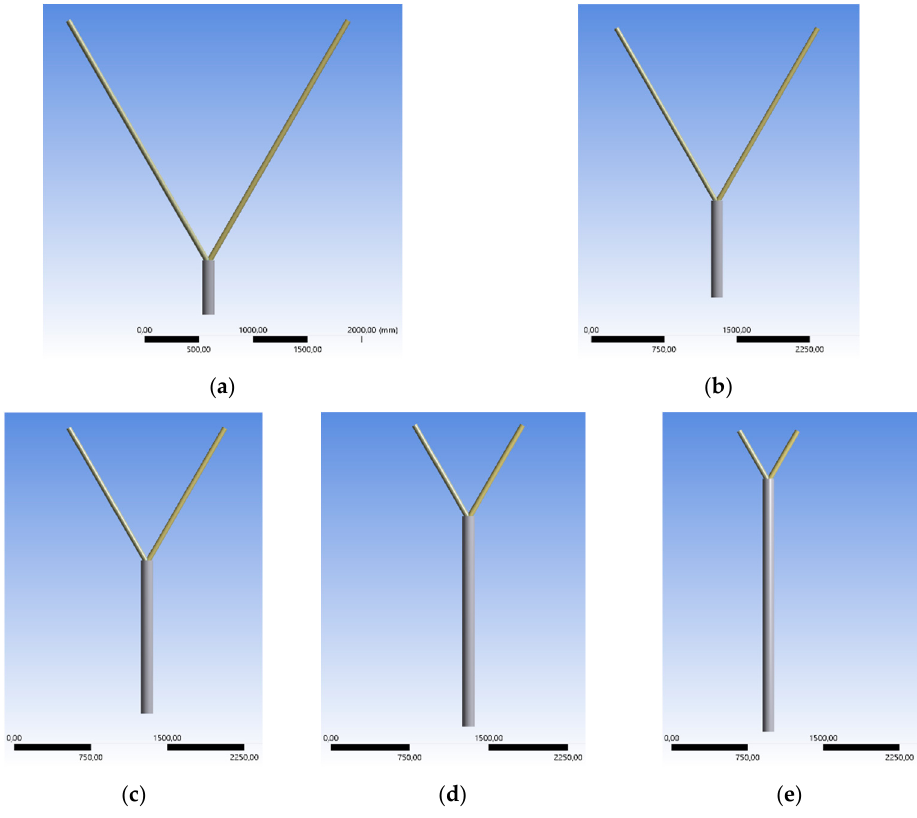
Figure 16. Variable Geometry with Chord Length 0.5–2.5 m.